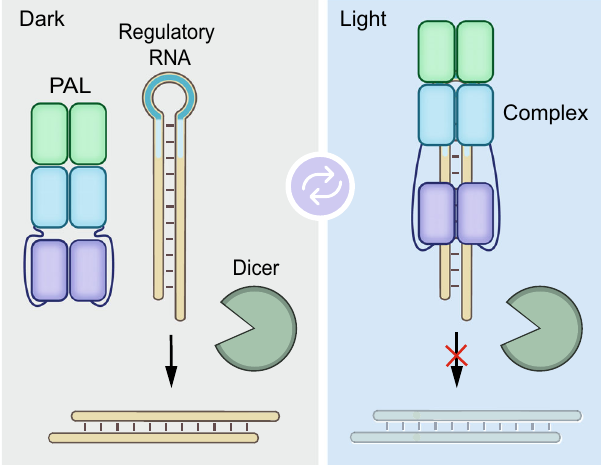
Fig. 1 General design of light-dependent regulatory RNAs. The PAL protein reversibly binds to its cognate RNA aptamer (highlighted in blue) embedded in the apical loop domain of a regulatory RNA (highlighted in light orange) in the light and thereby in fl uences regulatory RNA